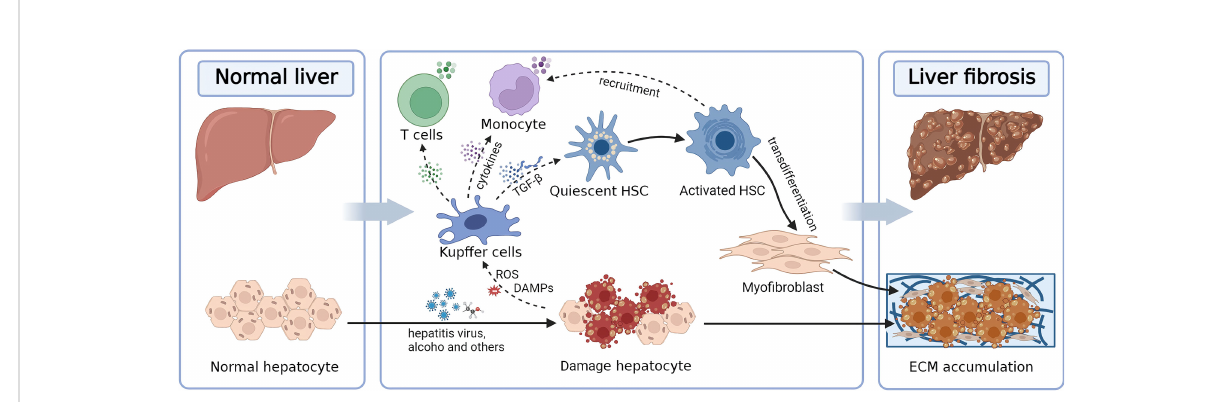
FIGURE 1 Diagram illustrating the pathological mechanisms underlying liver fi brosis. Hepatic fi brosis is induced by the imbalance between ECM production and degradation, driven by HSCs activated by hepatocyte injury. ECM, extracellular matrix; HSC, hepatic stellate cell; TGF- b , transforming growth factor- b